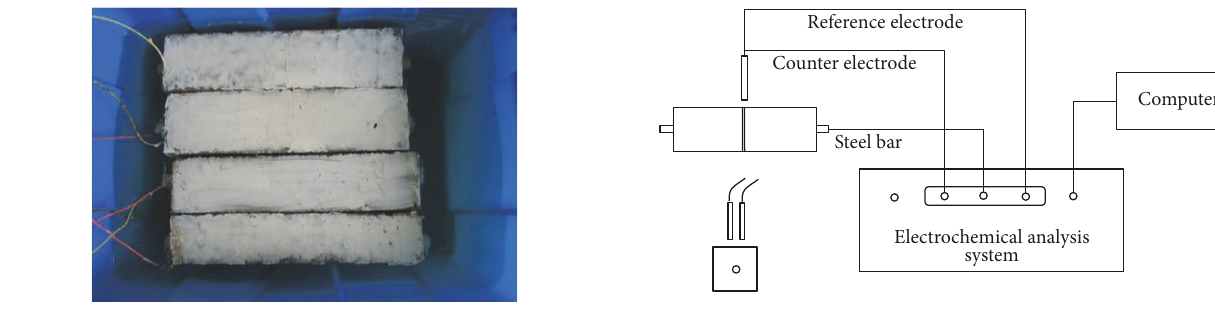
Figure 2: Experiment setup for accelerated chloride penetration test.